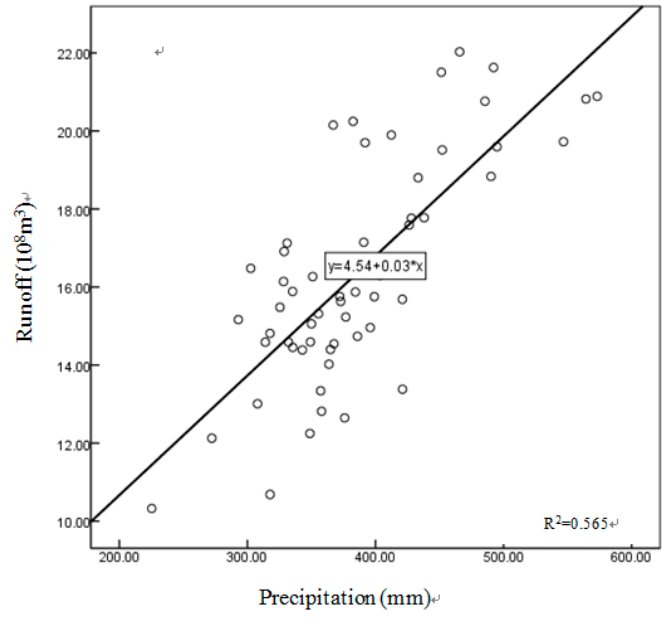
Figure 7. The correlation analysis between precipitation and runoff.